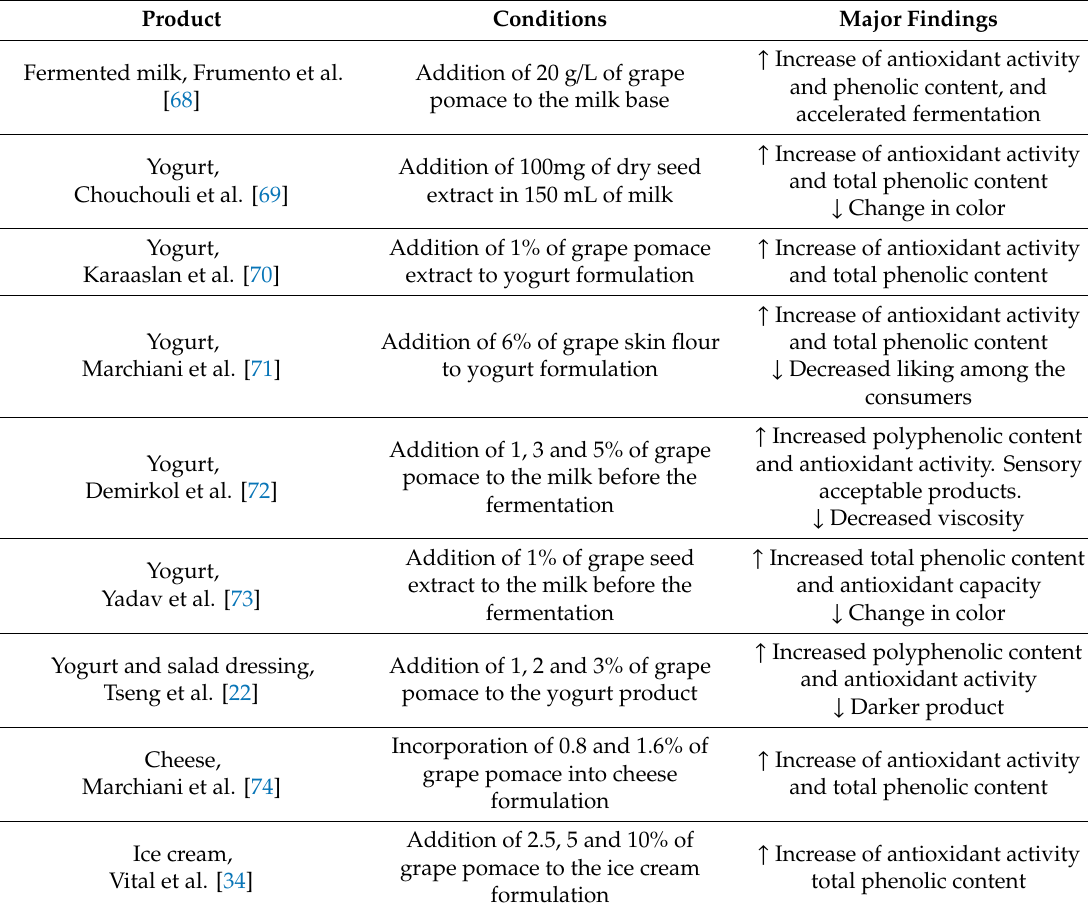
Table 4. E ff ect of addition of grape pomace to the dairy